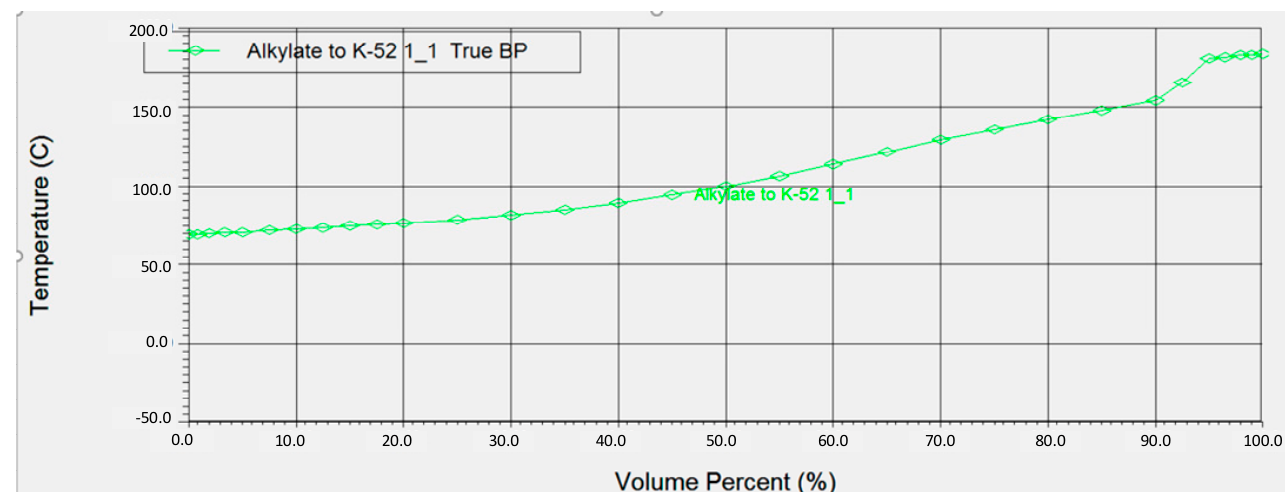
Figure A3. Feed K-52 TBP distillation blend.